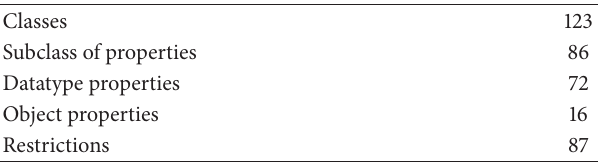
Table 1: Details of the financial